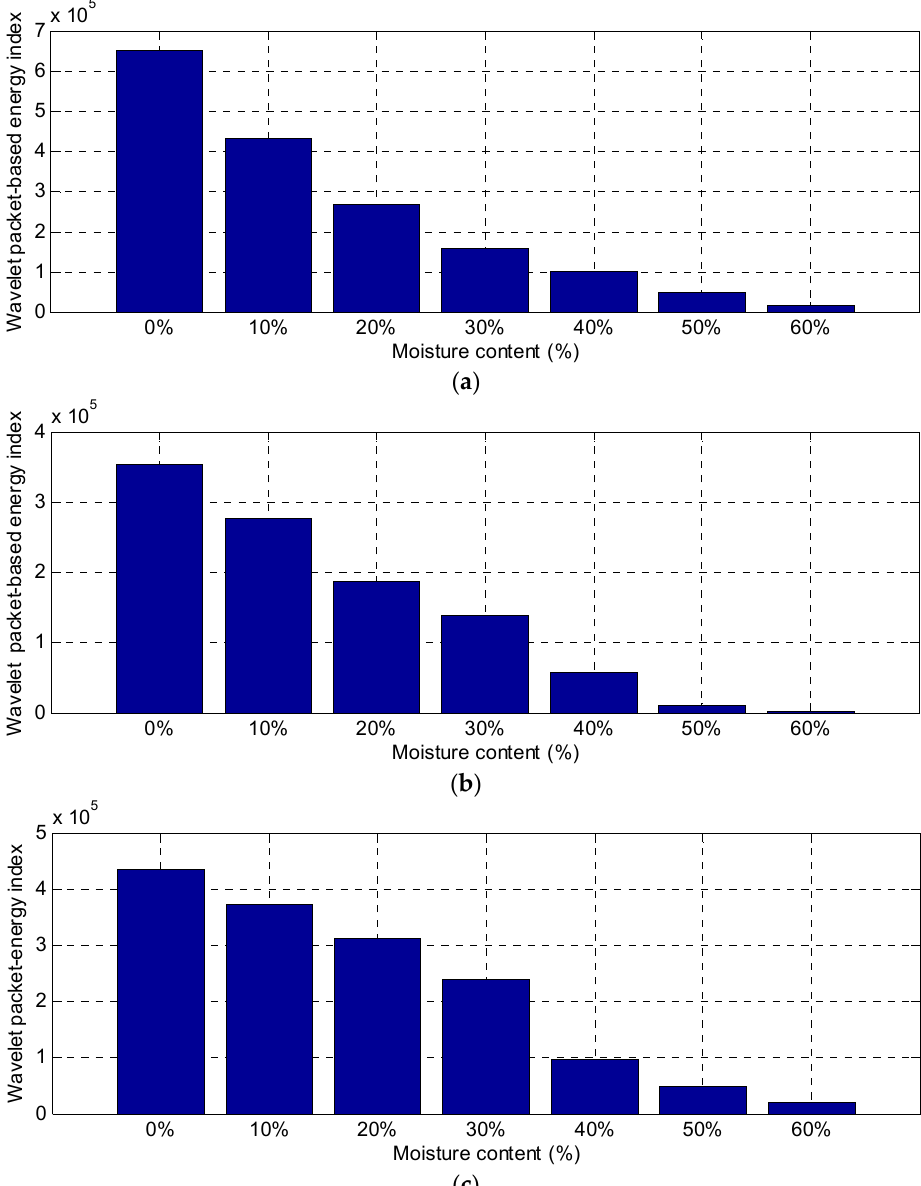
Figure 6. Energy indices of timber specimen with different moisture content. ( a ) Specimen 1; ( b ) specimen 2; ( c ) specimen 3.